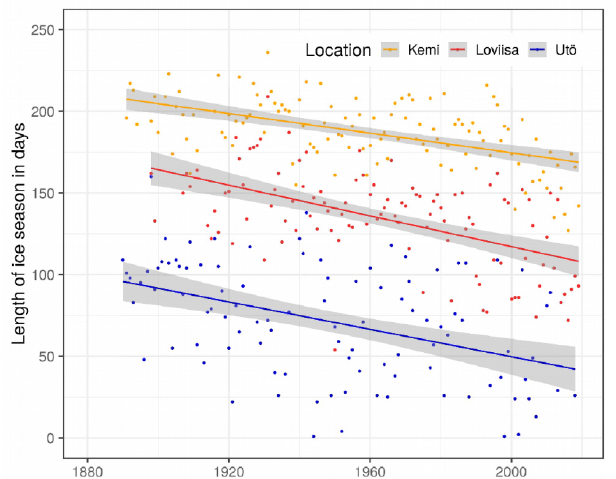
Figure 17. Length of the ice season in days at Kemi, Loviisa, and Utö (Finland) during 1890–2019. Dots are the annual mean, and lines are the linear trend with 95% confidence intervals. Data are available from the ice service of the Finnish Meteorological Insti- tute, Helsinki, Finland, upon request (https://en.ilmatieteenlaitos.fi/ ice-conditions, last access: 6 March